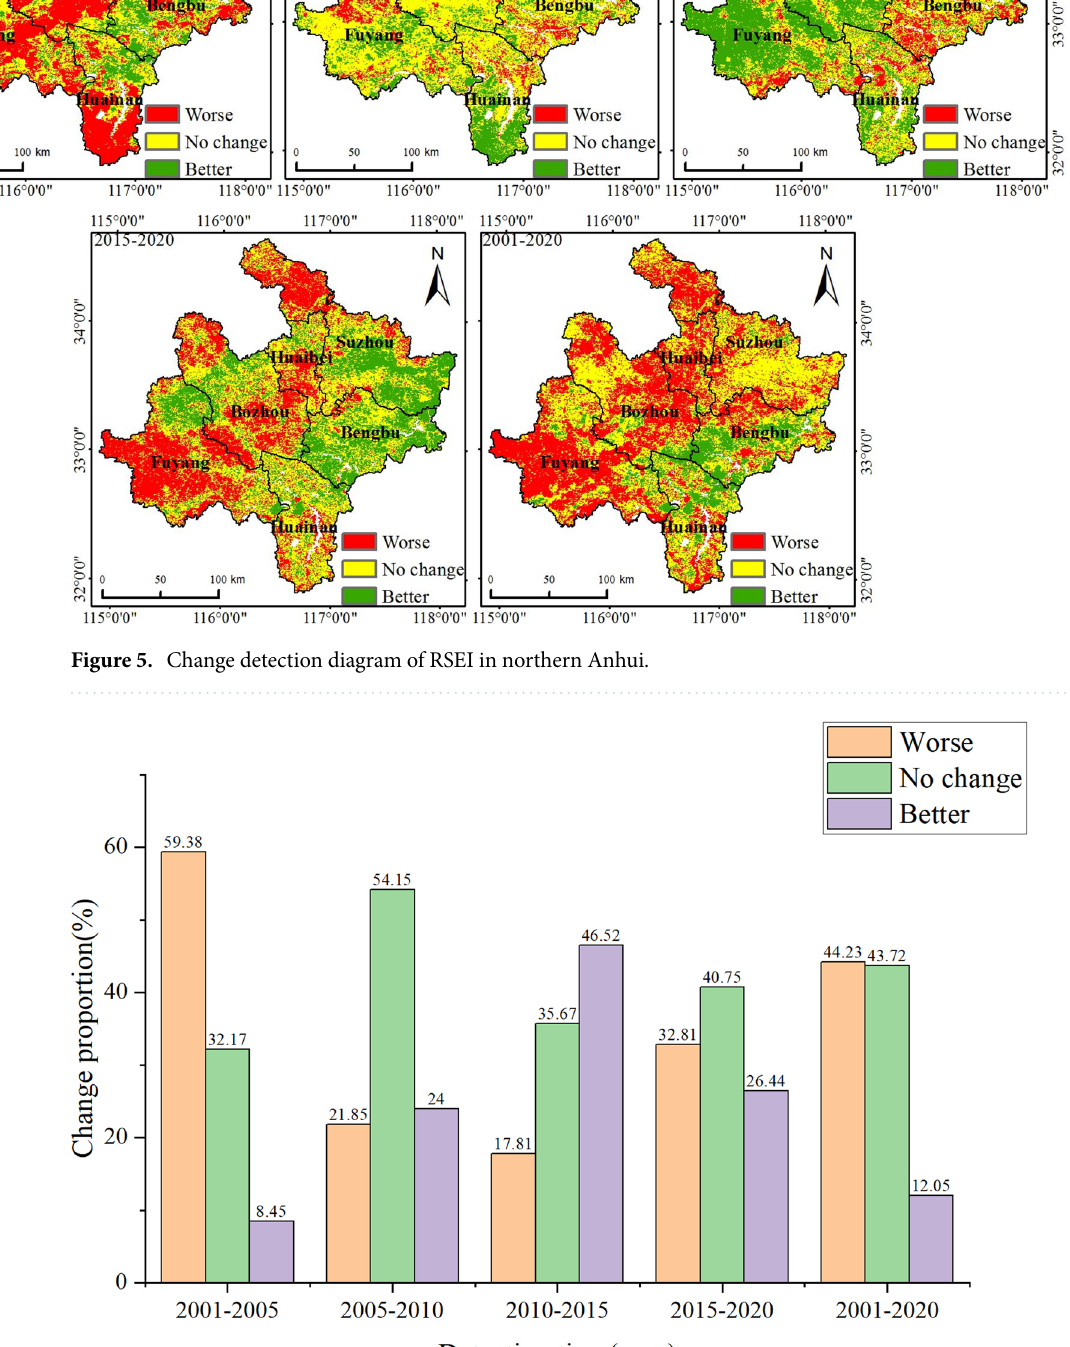
Figure 6. Scale map of RSEI change detection in northern